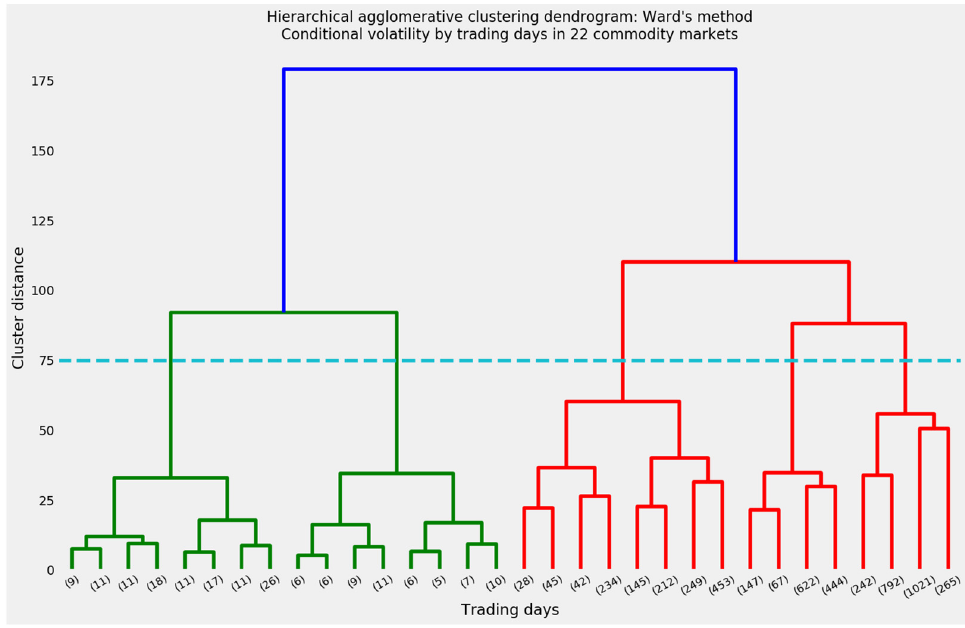
Figure 10. Hierarchical agglomerative clustering of commodity markets—A dendrogram truncated after four levels with a horizonal cut indicating five clusters.